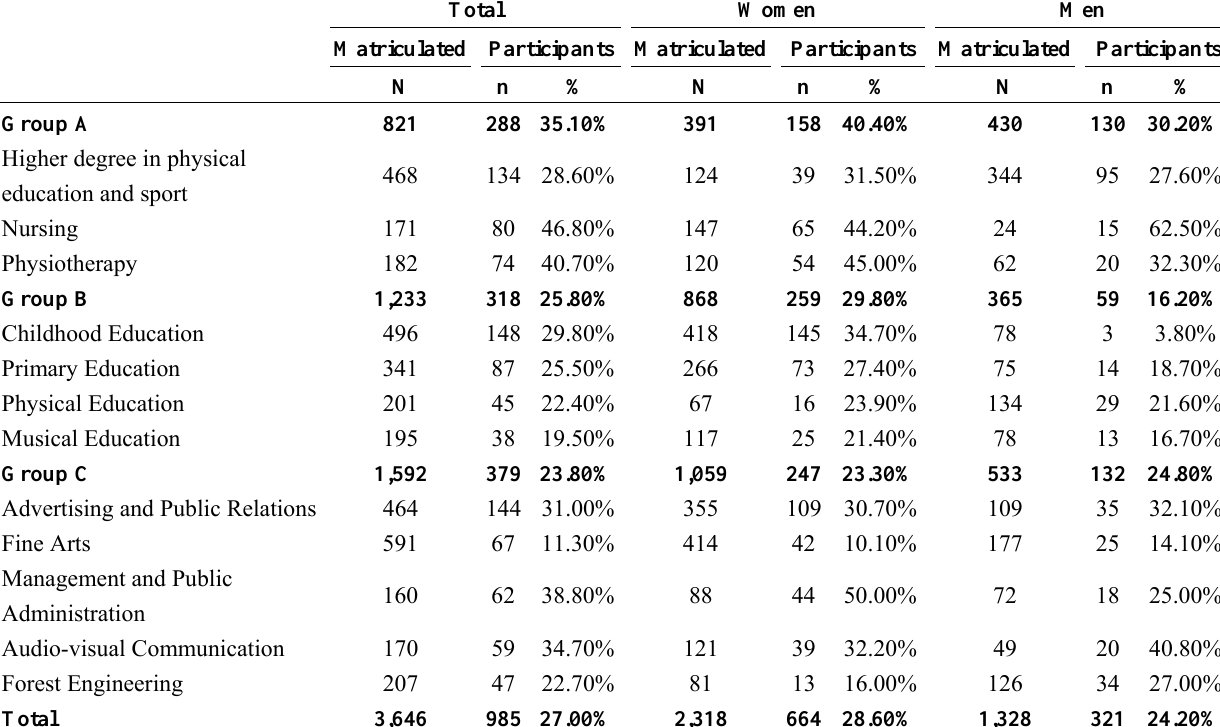
Table 1. Sample participation according to gender and academic discipline. Total Women